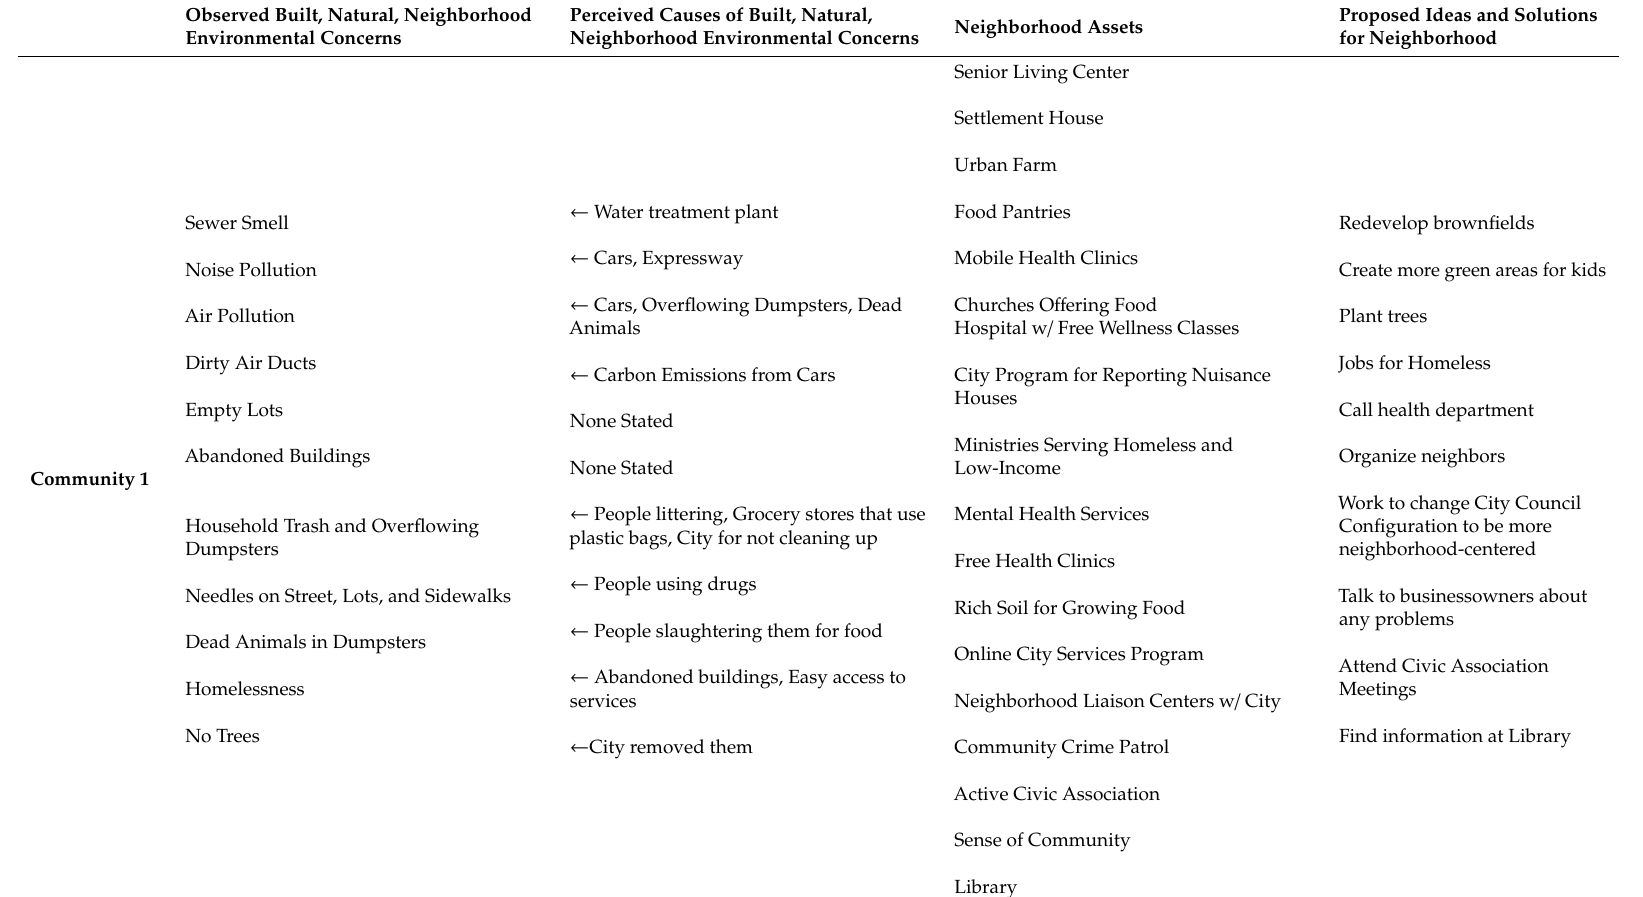
Table 2. Focus Group